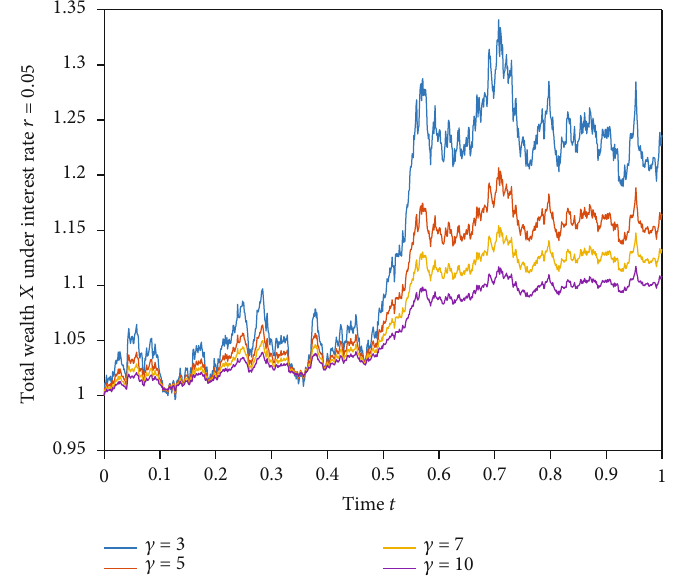
Figure 4: The relationship between total wealth and time under di ff erent